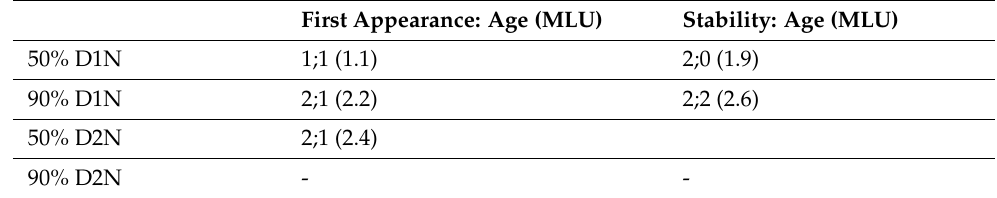
Table 3. Max’ D prosodification at different thresholds 9 (adapted from Tremblay 2006).